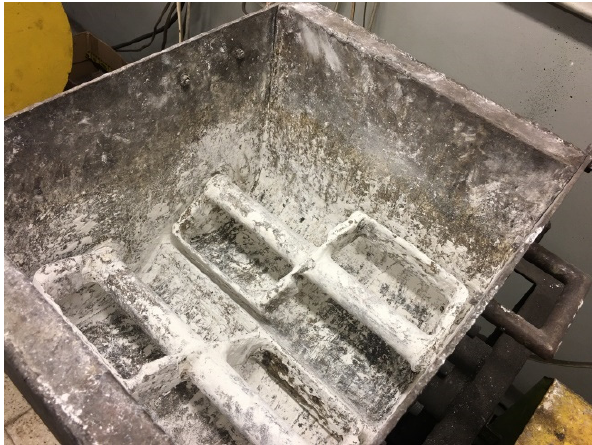
Figure 5. The view of Z-blade mixer used in the test for material preparation.